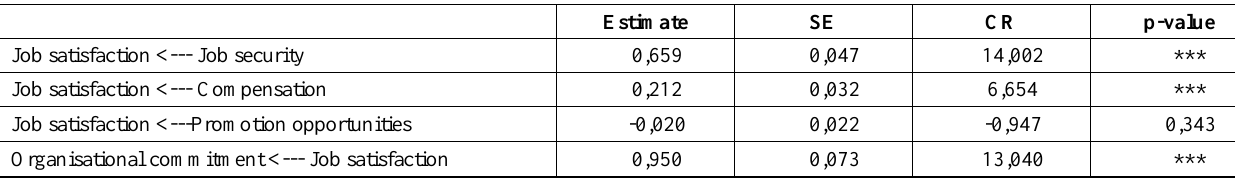
Table 1: Model 1 parameter estimates and